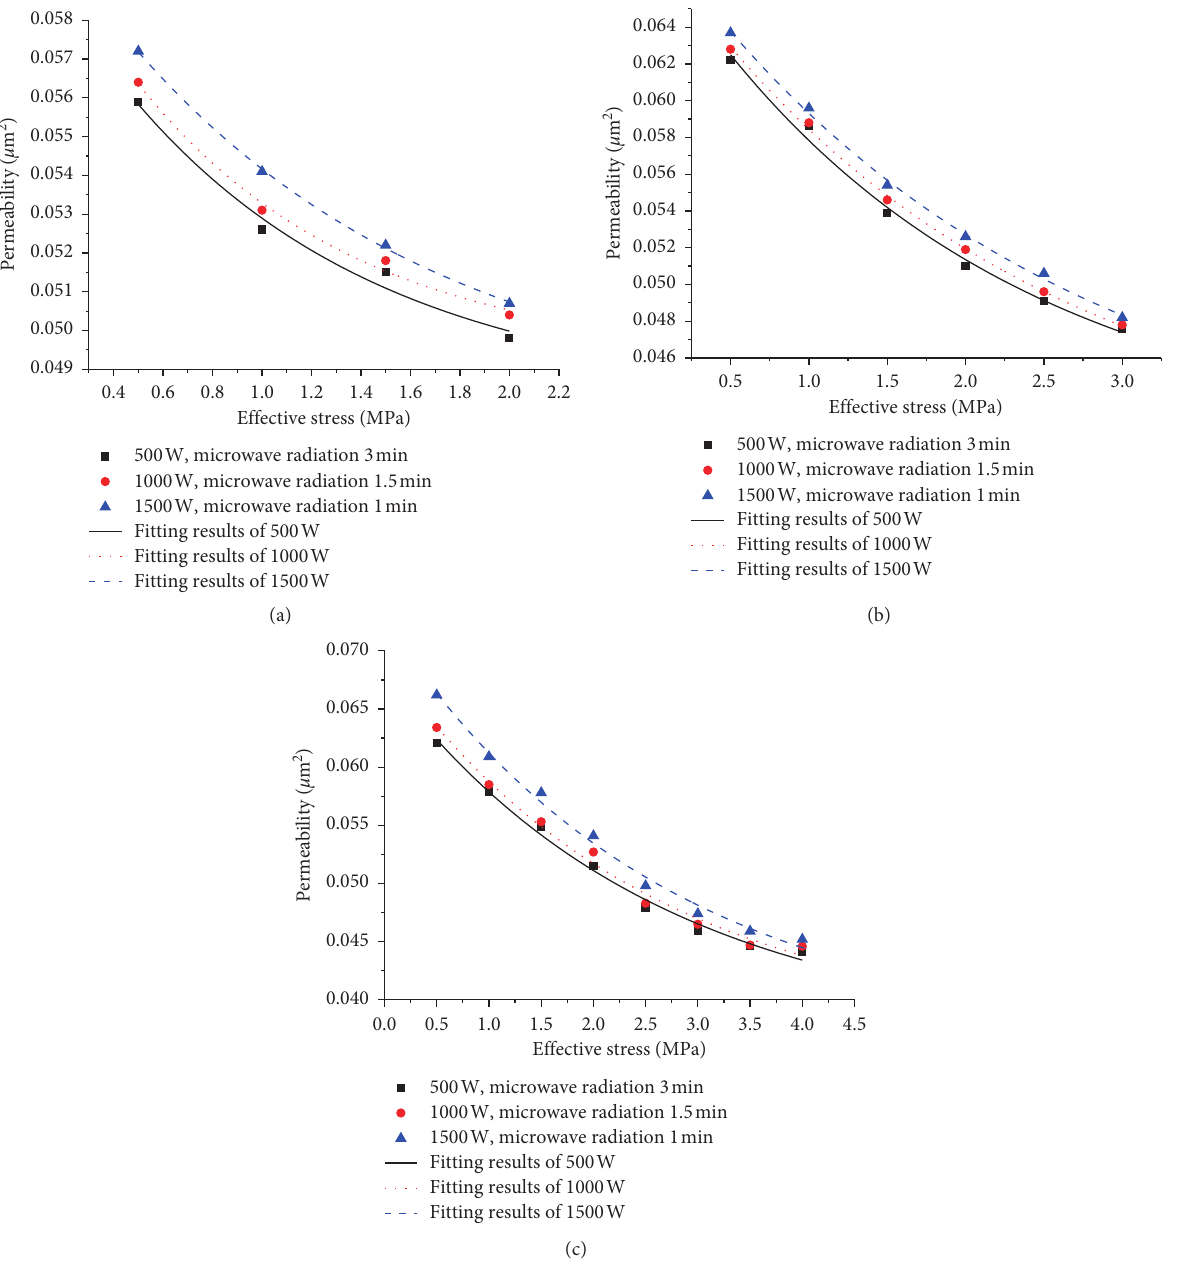
Figure 10: Variation trends of permeability with the same energy input and different axial and confining